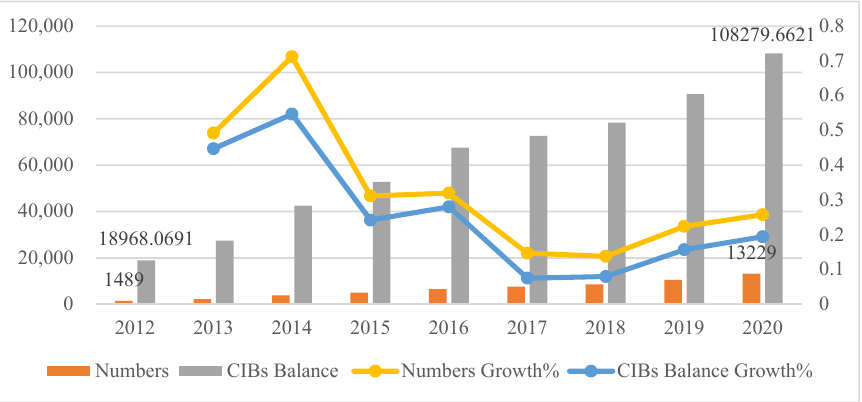
Figure 1. Number and balance of city investment bonds (CIBs) from 2013 to 2020. Source: National Statistical Bureau and Wind